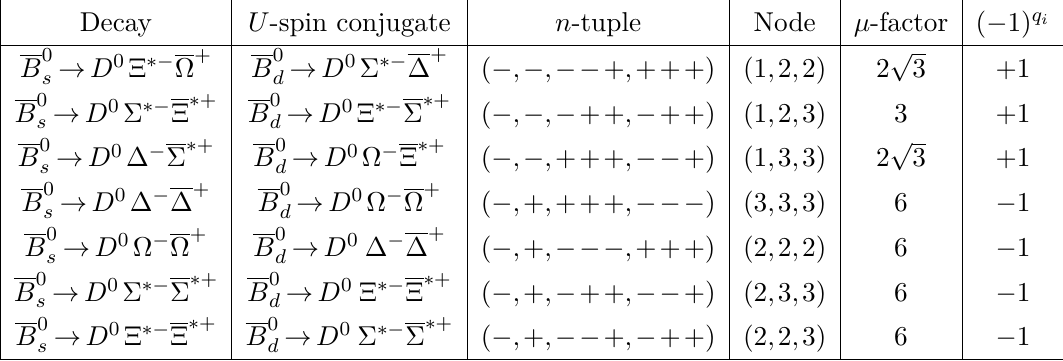
Table 7 . The mapping of the U -spin pairs of B 0 → D 0 Ω −